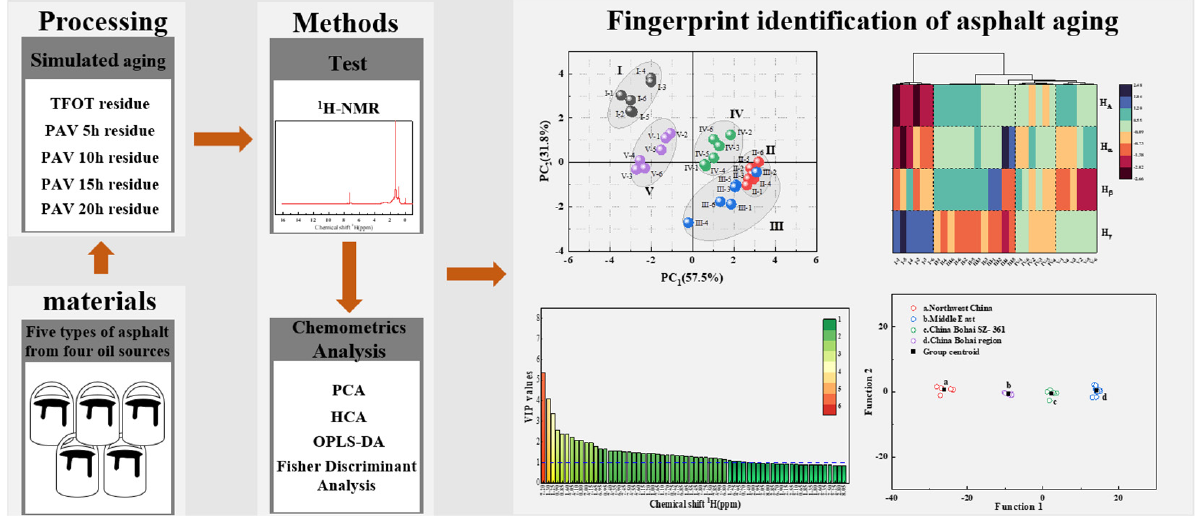
Figure 1. Flow chart of experimental plan procedure.